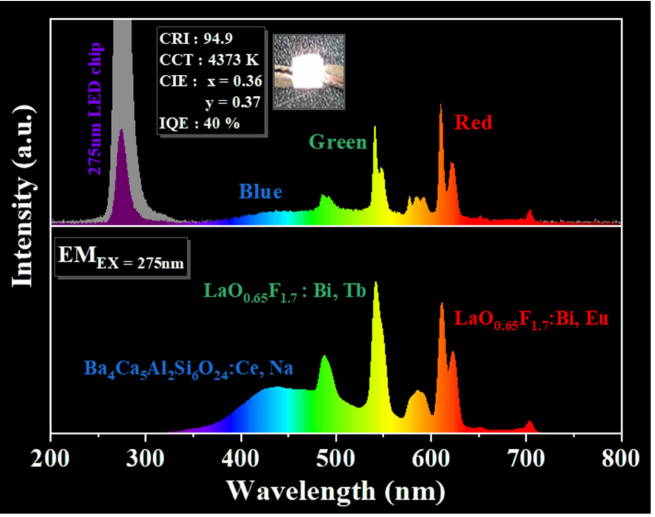
Figure 6. The emission spectra of RGB phosphors (La 0.94 Bi 0.01 Eu 0.05 O 0.65 F 1.7 , La 0.89 Bi 0.01 Tb 0.1 O 0.65 F 1.7 , and Ba 3.8 Ce 0.1 Na 0.1 Ca 5 Al 2 Si 6 O 24 ) under 275 nm UV excitation and the electroluminescence spectra and a photograph of the RGB pc LED under 3.2 V and 20